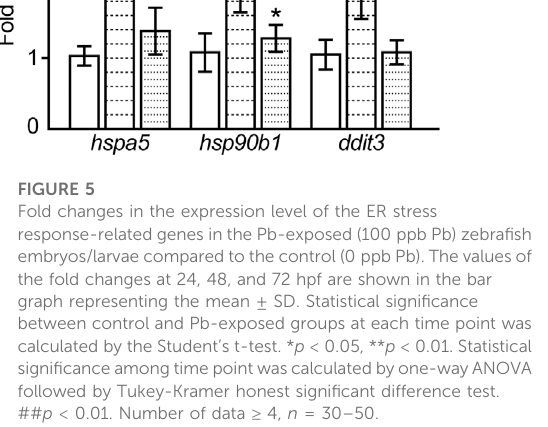
strain,sensitivity of fi sh toPbexposure,starttimeofexposure, and/or